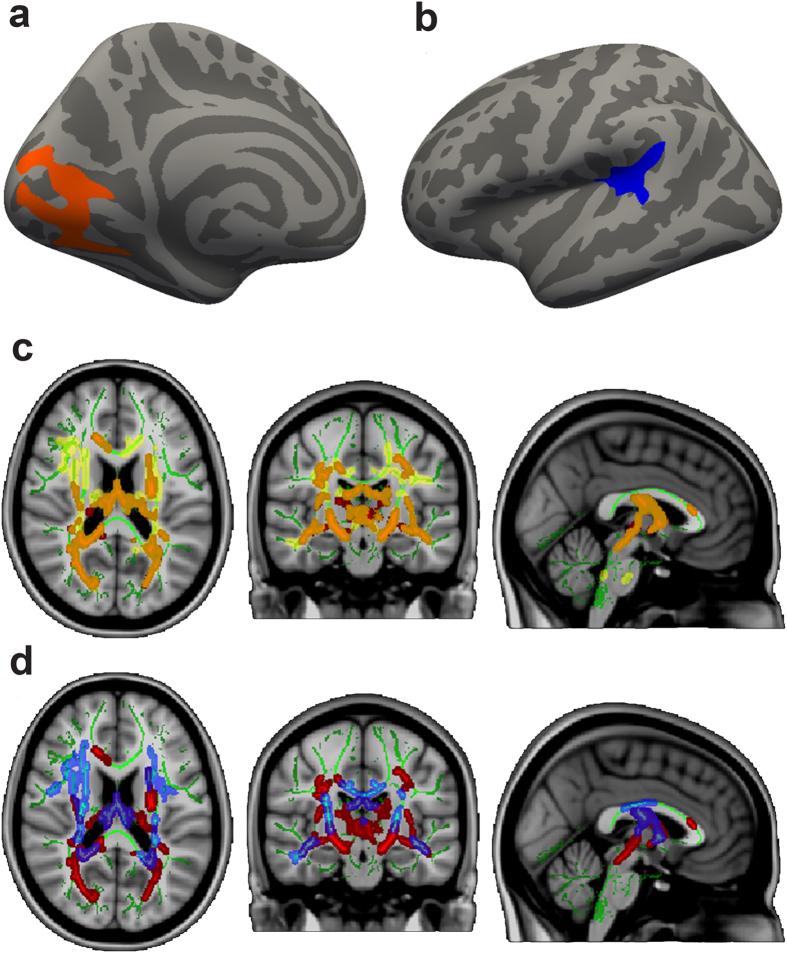
Differences in cortical thickness, volume and white matter microstructure between Wolfram and Control groups.(a) Cortical thickness was lower in the pericalcarine area in Wolfram Syndrome compared to Controls, after multiple comparison corrections, p = 0.0001. (b) Cortical volume was greater in the superior temporal area in Wolfram Syndrome compared to controls, after multiple comparison correction, p = 0.035. (c) Fractional anisotropy (FA, red) was lower, and radial diffusivity (RD, yellow) was higher compared to controls, after multiple comparison correction. Overlap between FA and RD differences are shown in orange. (d) Fractional anisotropy (FA, red) was lower, and axial diffusivity (AD, blue) was higher compared to controls, after multiple comparison correction. Overlap between FA and AD differences are shown in purple.